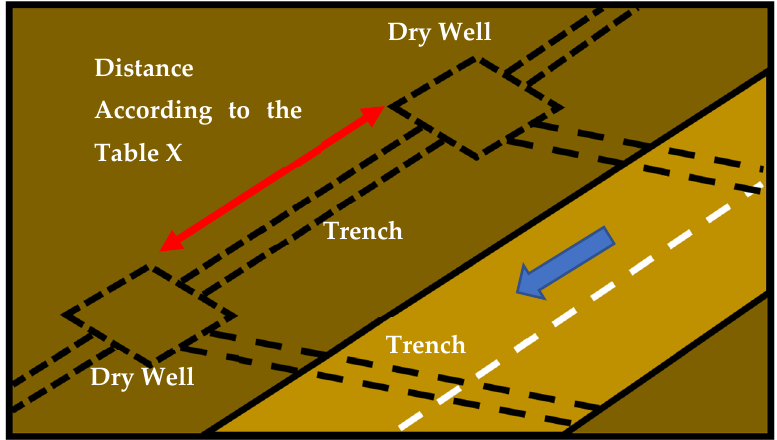
Figure 6. Dry well (caixa seca) scheme.